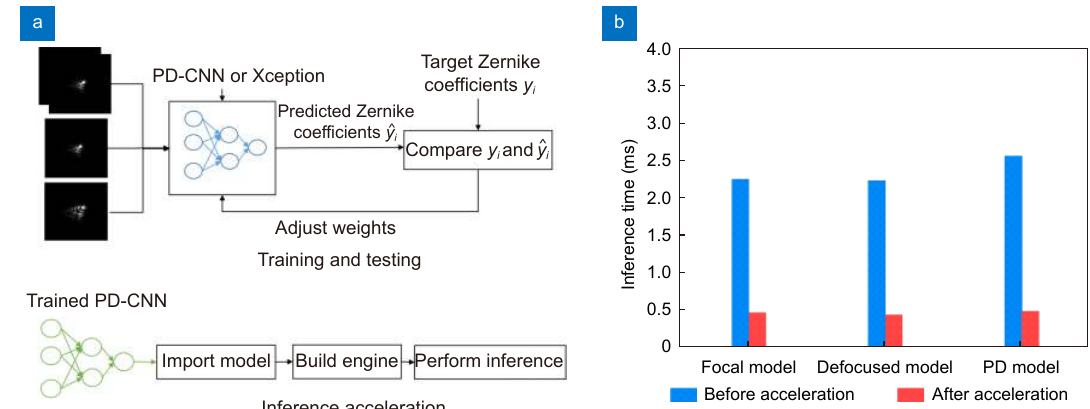
Fig. 11 | ( a ) The experiments of training and testing processes and inference acceleration. During training and testing processes, two networks were used, phase-diversity CNN (PD-CNN) and Xception. PD-CNN includes three convolution layers and two full connection layers. For each network, three sets of comparative experiments are set as following, inputting the focal and defocused intensity images separately, and inputting the focal and defocused intensity images at the same time. During the inference acceleration process, the trained model is optimized by Tensor- RT. ( b ) The inference time before and after acceleration with NVIDIA GTX 1080Ti. Figure reproduced from: (a, b) ref. 82 , under a Creative Com- mons Attribution License 4.0.